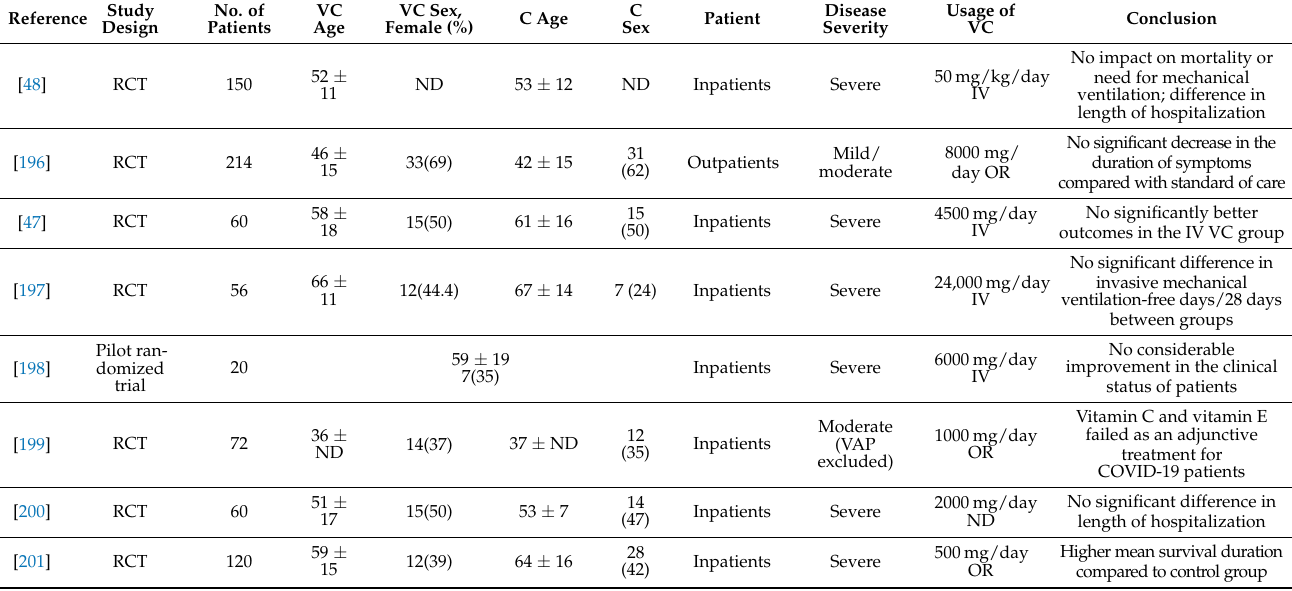
Table 4. RCTs conducted on the topic of VC use in COVID-19